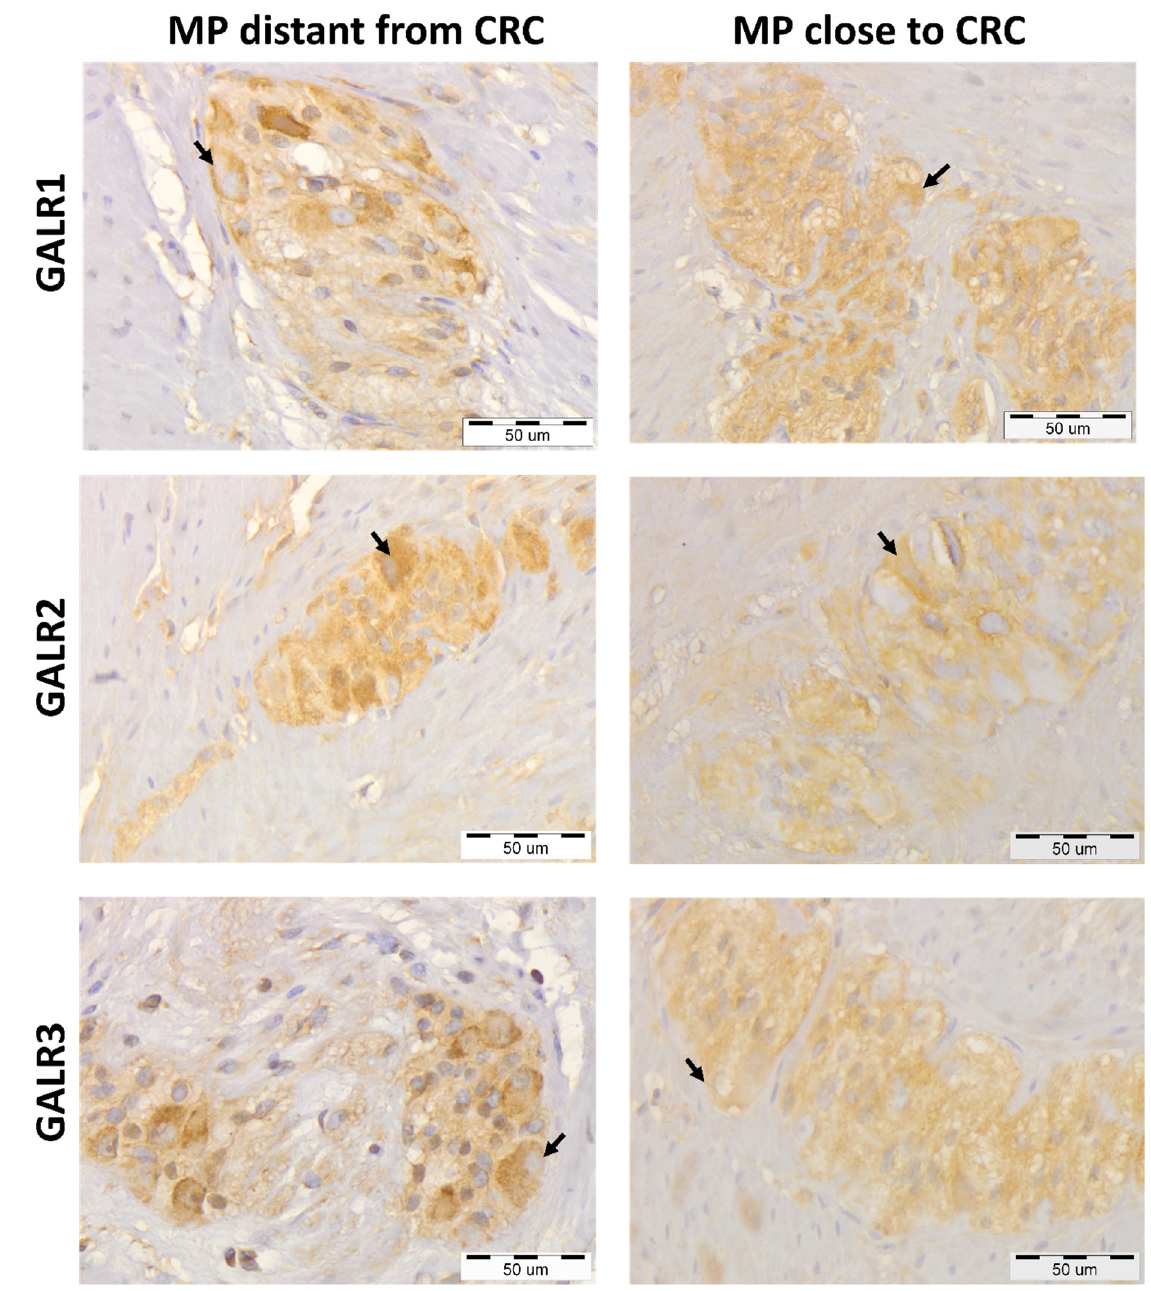
Figure 1. Immunohistochemical expression of galanin receptors (GALR1, GALR2, and GALR3) in myenteric plexuses (MP) distantly located from the colorectal cancer (CRC) tissue compared with their expression in the myenteric plexuses in the vicinity of cancer invasion of the same, representative CRC patients (n = 31). Neurons expressing respective GALRs are marked by arrows. Total magnification: 400×.